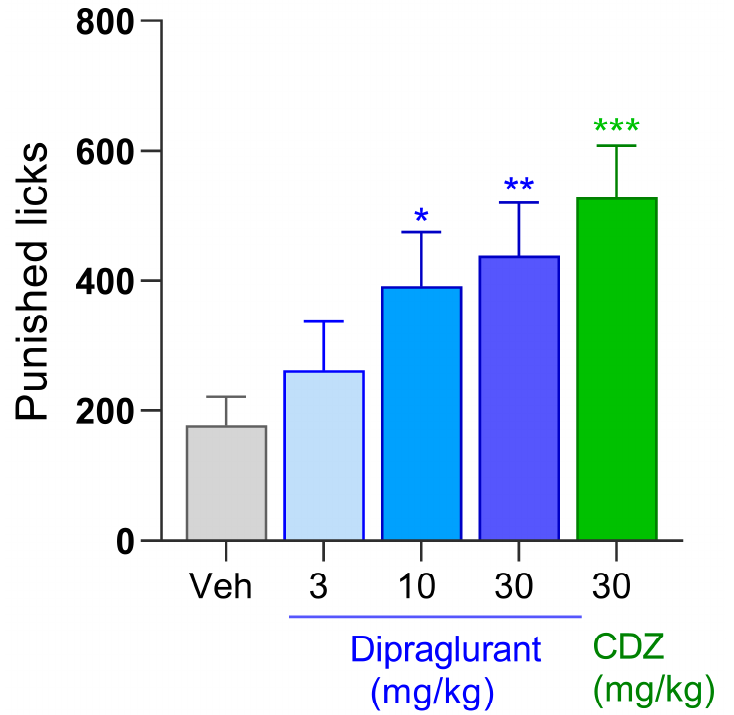
Figure 3. Number of punished licks made by Sprague-Dawley rats ( n = 8–10/group) during the Vogel test. Animals were treated with either dipraglurant (3, 10, 30 mg/kg p.o.), vehicle (distilled water, p.o.) or chlordiazepoxide (CDZ; 30 mg/kg, i.p.) Each point represents the observed mean ± SEM, * p < 0.05, ** p < 0.01, *** p < 0.001 compared to vehicle (Veh). 3.4. Anticompulsive E ff ect of Dipraglurant in the Marble Burying Test